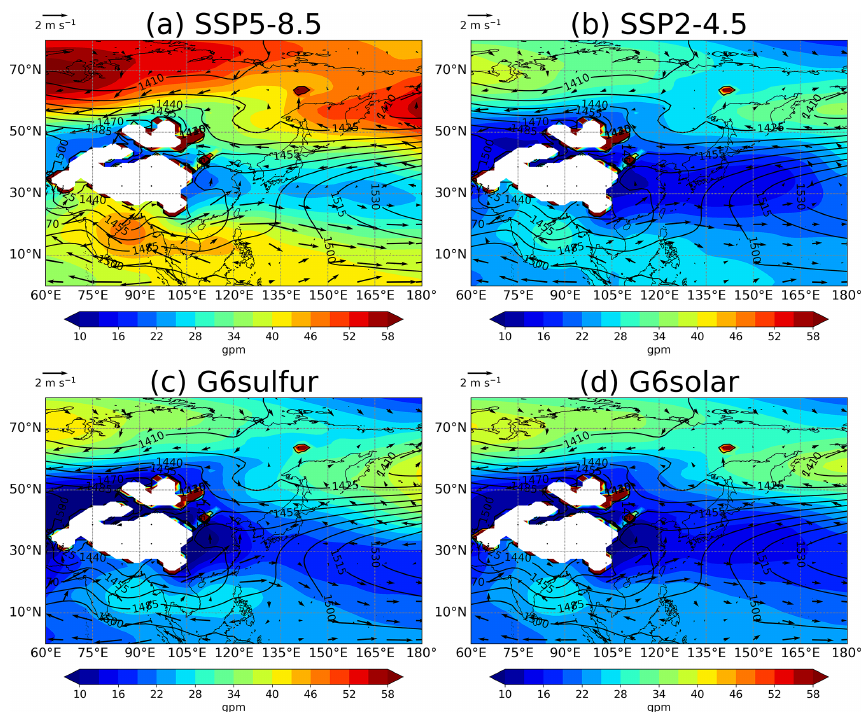
Figure 1. Absolute changes in MJJAS mean geopotential height (shaded; unit in geopotential metres or gpm) and wind (vectors) at 850hPa for the future period of 2071–2100 relative to the historical baseline during 1981–2010. Black contours show the MJJAS mean 850hPa geopotential height during the historical baseline period. Areas with a surface pressure below the 850hPa level are shown in white.